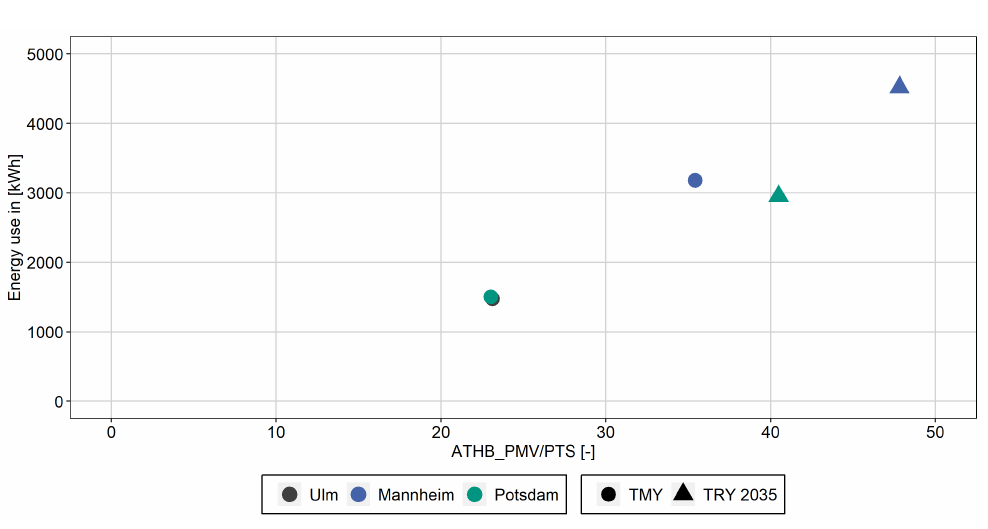
Figure 7. Energy use and percentage of discomfort hours for PMV/PTS greater than 1 (“slightly warm”) for all locations and climate